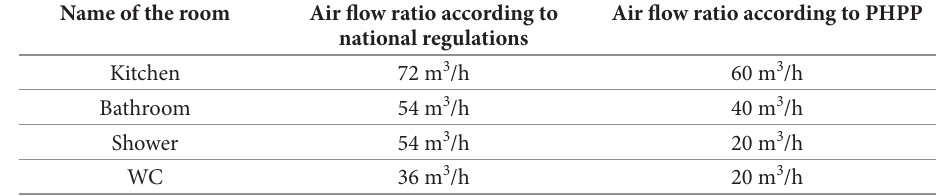
Table 2. Required extracted air flow ratio from the